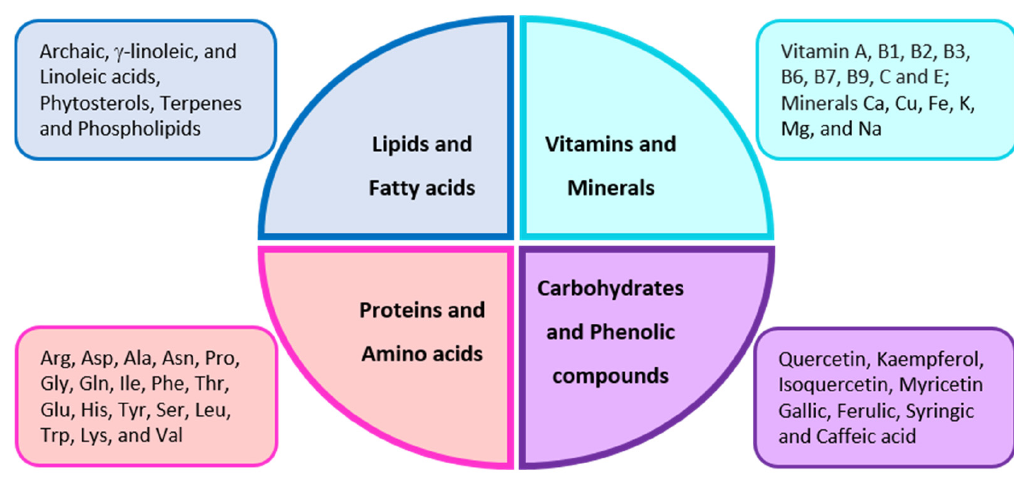
Figure 5. Main identified constituents of bee pollen and bee bread.